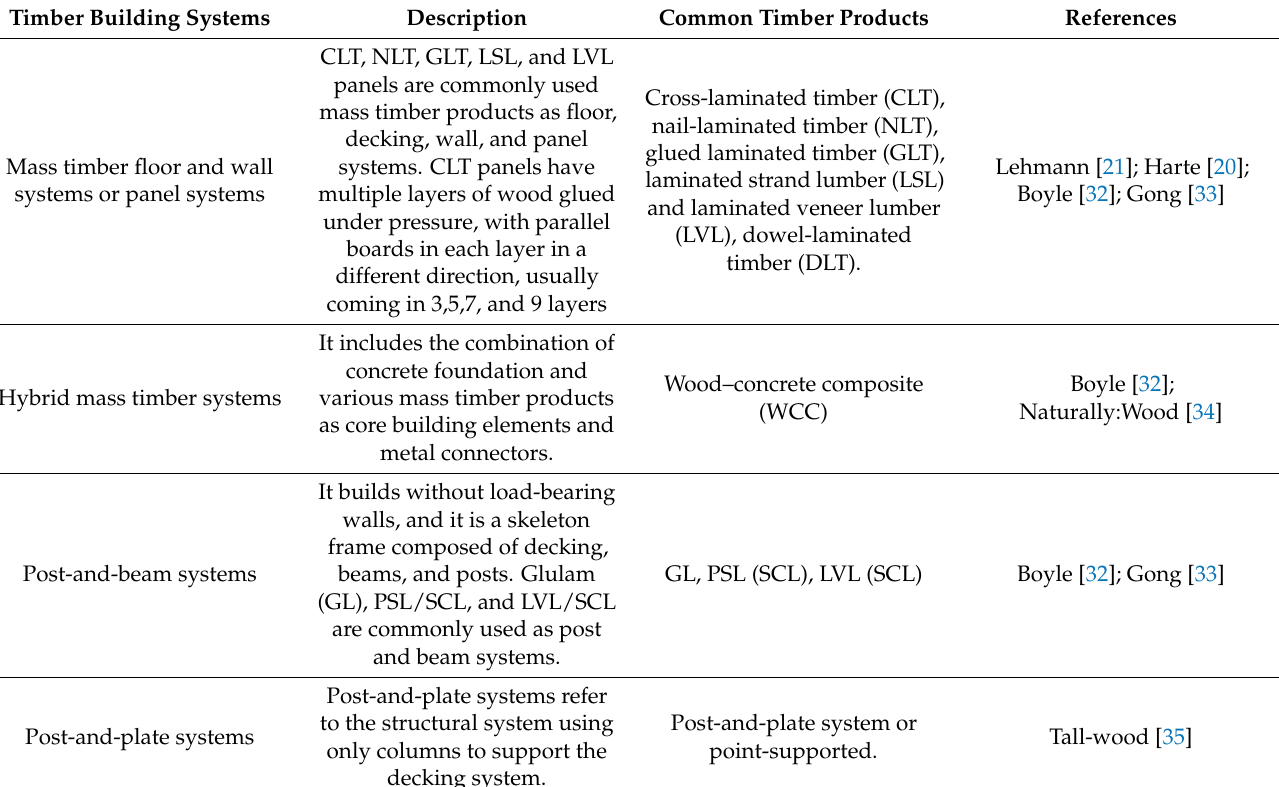
Table 1. Types of mass timber building